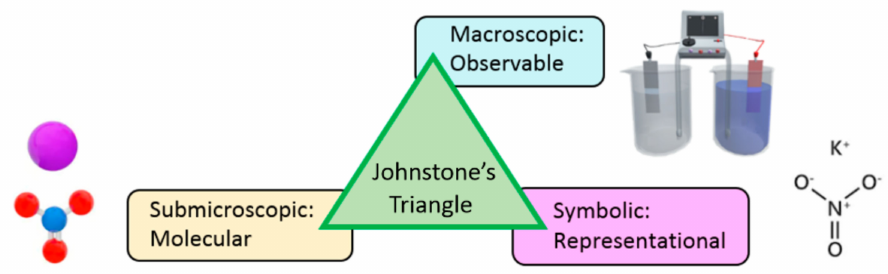
Figure 1. Johnstone’s triangle, representing the three levels of chemistry